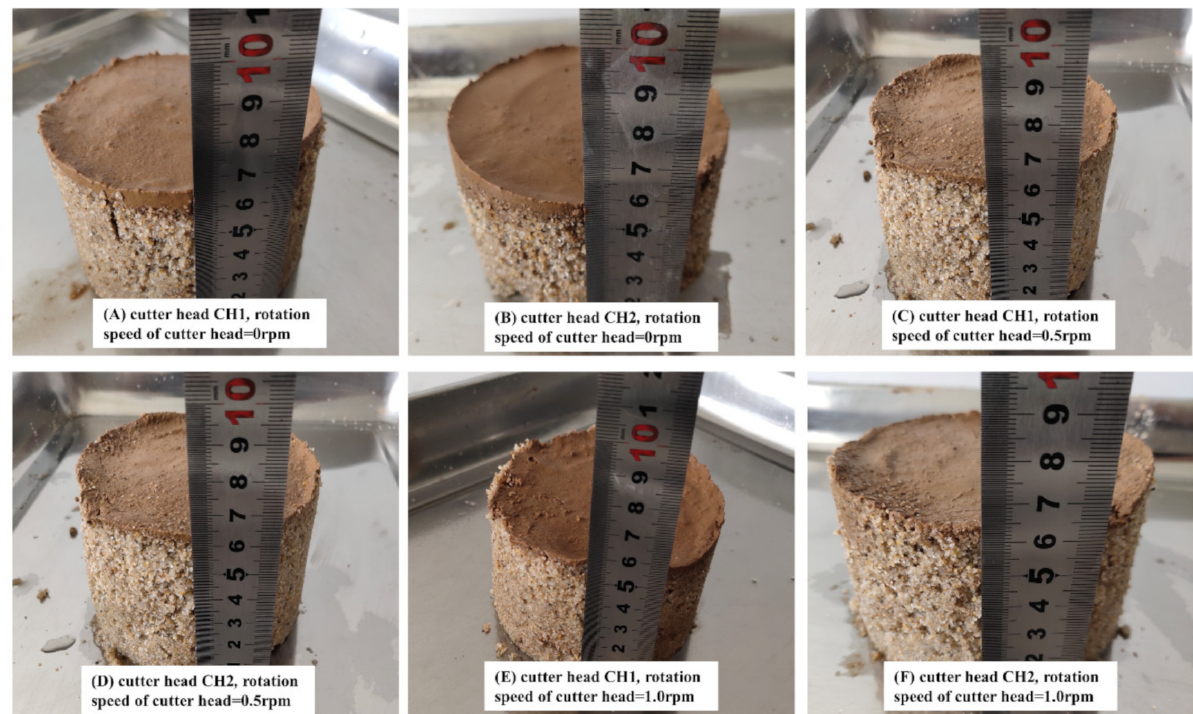
Figure 13. The final filter cake states: ( A ) cutter head CH1, rotation speed of cutter head = 0 rpm, ( B ) cutter head CH2, rotation speed of cutter head = 0 rpm, ( C ) cutter head CH1, rotation speed of cutter head = 0.5 rpm, ( D ) cutter head CH2, rotation speed of cutter head = 0.5 rpm, ( E ) cutter head CH1, rotation speed of cutter head = 1.0 rpm, ( F ) cutter head CH2, rotation speed of cutter head = 1.0